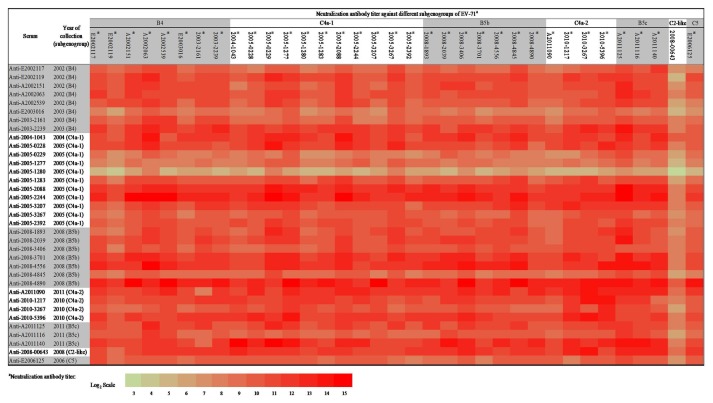
Serum neutralization antibody titers against different subgenogroups of enterovirus 71 (EV-71).The 35 serum samples were tested at two-fold serial dilutions against one hundred CCID50 of EV-71 viruses. The neutralization titers were defined as the highest dilution fold at which the cytopathic effects were inhibited in 50% of cells. The titer values were log2 transformed and were represented by different colors, as indicated by the log2 scale. The star symbol indicates a significant difference when compared to subgenogroup C2-like group (p<0.05).